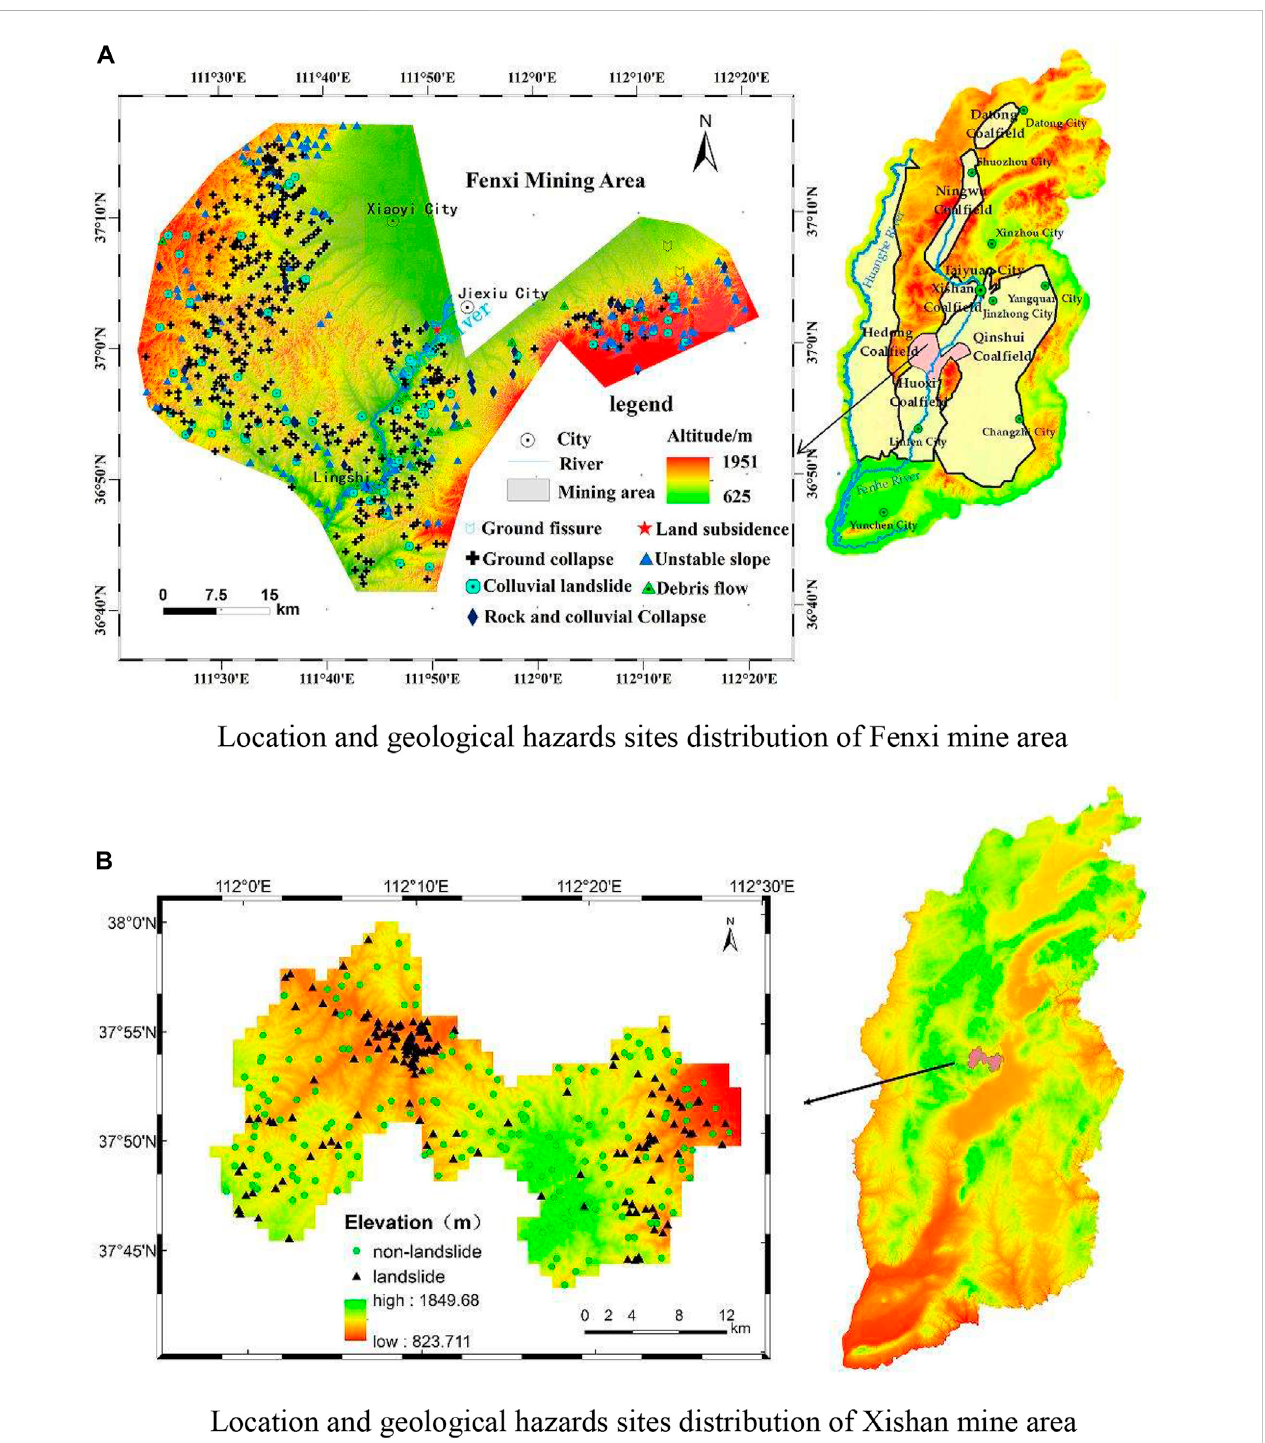
FIGURE 1 Location and distribution of geological hazard sites of the study area. (A) Location and geological hazards sites distribution of Fenxi mine area, (B) Location and geological hazards sites distribution of Xishan mine